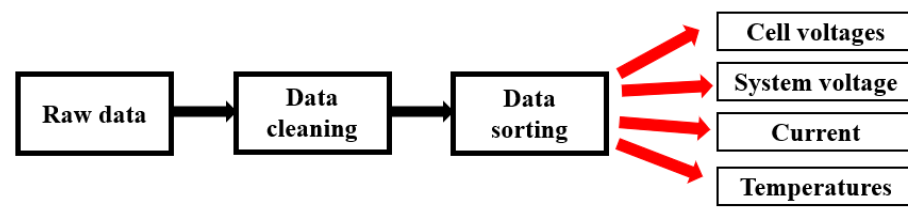
Figure 3. The structure of data processing.